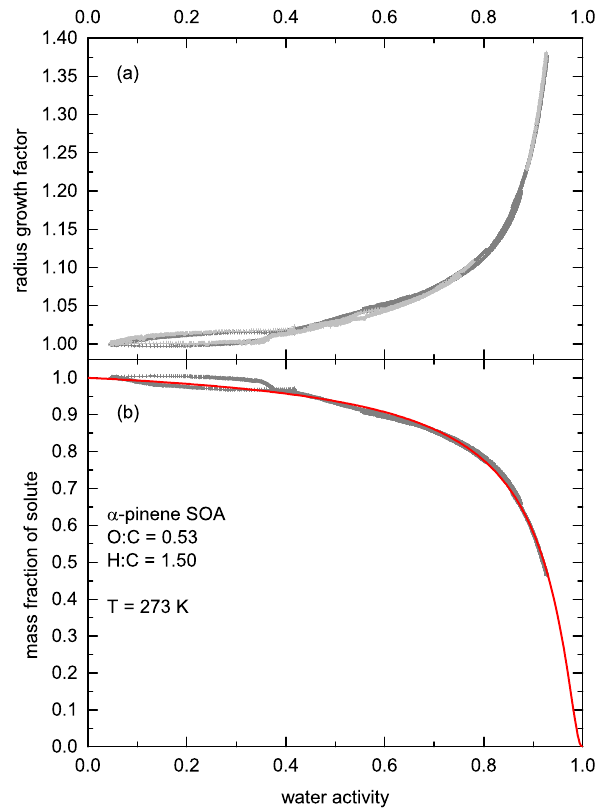
Figure A4. (a) Radius growth factor of a α -pinene SOA parti- cle (O:C = 0.53) at 273K as derived from Mie resonance spec- troscopy (light-gray crosses) and from mass balance (dark gray crosses) yielding 1 . 40 ± 0 . 05gcm − 3 for the density of the pure so- lute. (b) Mass fraction of solute vs. water activity calculated from the data of panel (a) . The red line represents the fit according to Eq. (A9). (A fit to a single parameter, κ , for describing hygroscopic growth as in Pajunoja et al. (2015) yields a value of 0 . 081 ± 0 . 005 Petters and Kreidenweis,